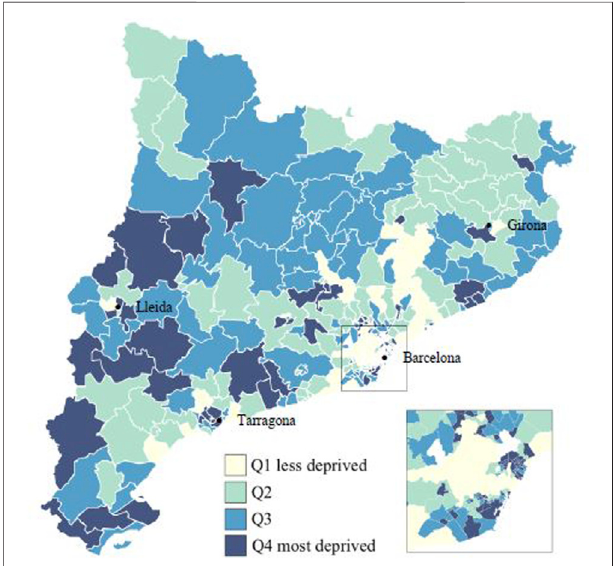
FIGURE 2 | Composite socioeconomic index (ISC) in quartiles for the health areas in Catalonia, 2019.